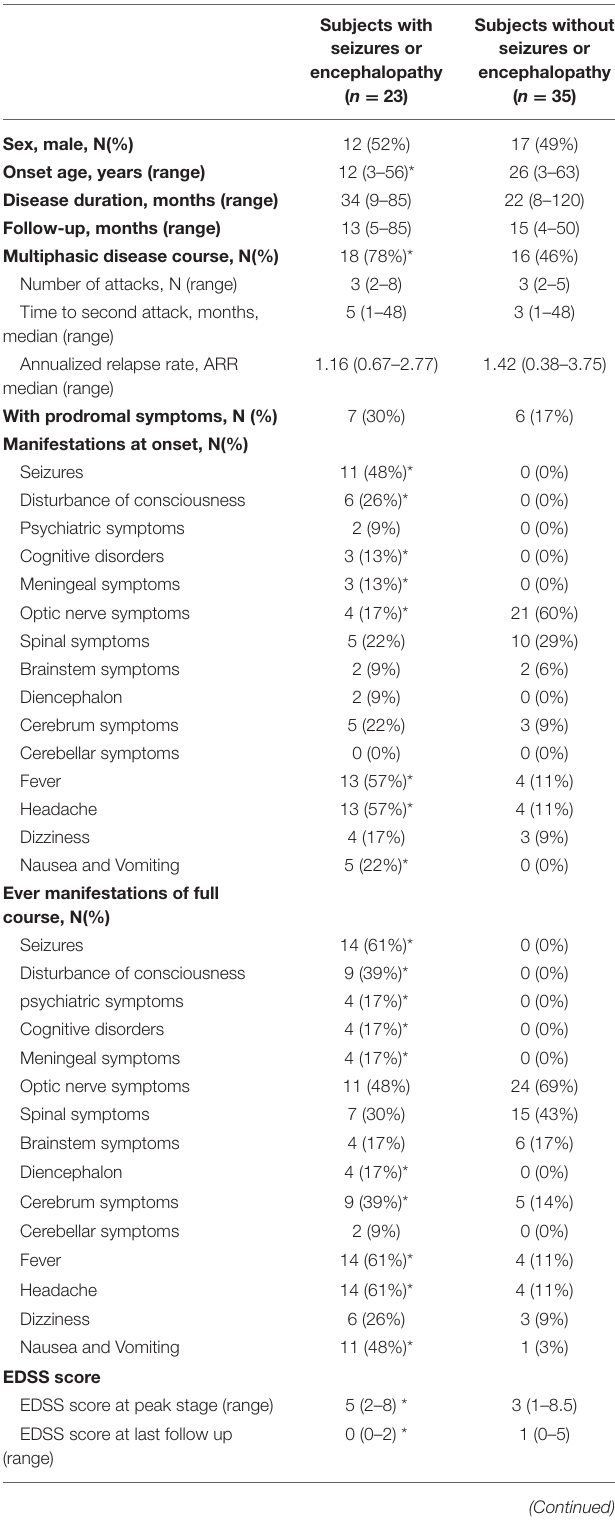
TABLE 1 | Comparison of clinical features between MOG-IgG positive subjects with or without seizures and/or encephalopathy.